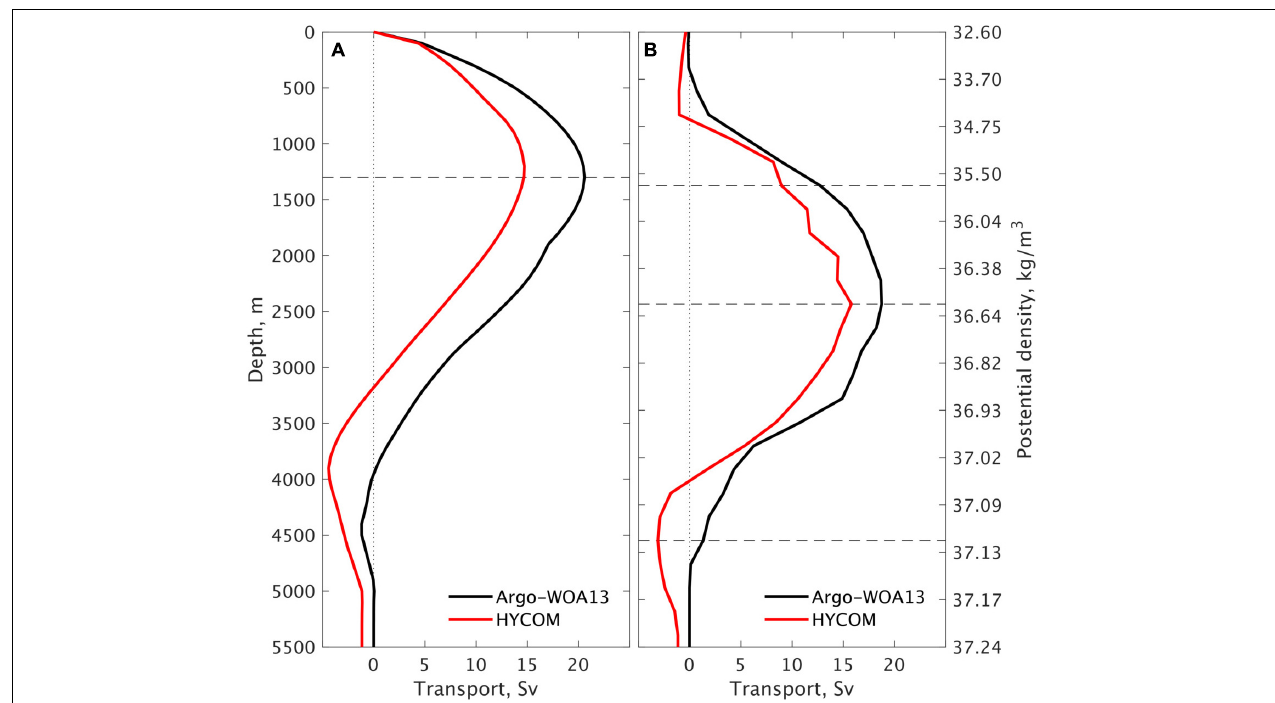
FIGURE 5 | Long-term mean meridional overturning streamfunction (in Sv) at 34 ◦ S with respect to (A) depth and (B) potential density in σ 2 . Observations based on monthly mean Argo-WOA13 profiles; model results based a global 1/12 ◦ HYCOM simulation